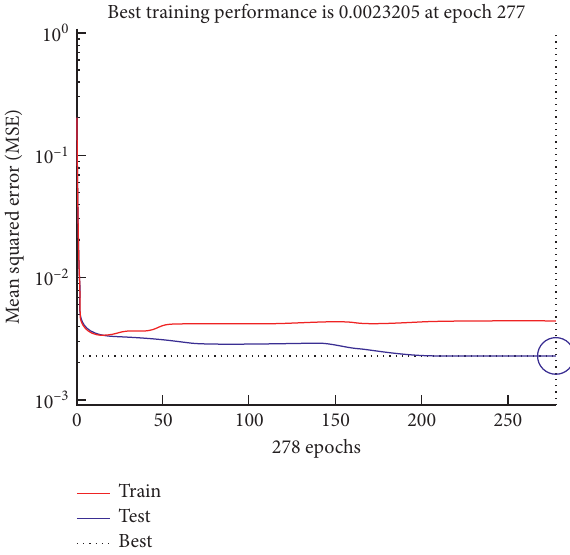
Figure 9: Training error convergence process